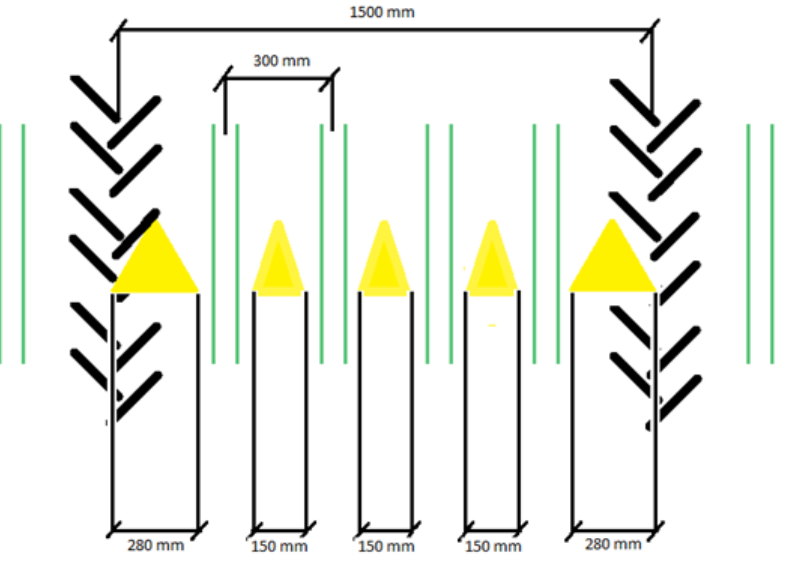
Figure 5. Arrangement of the nozzles and working width.